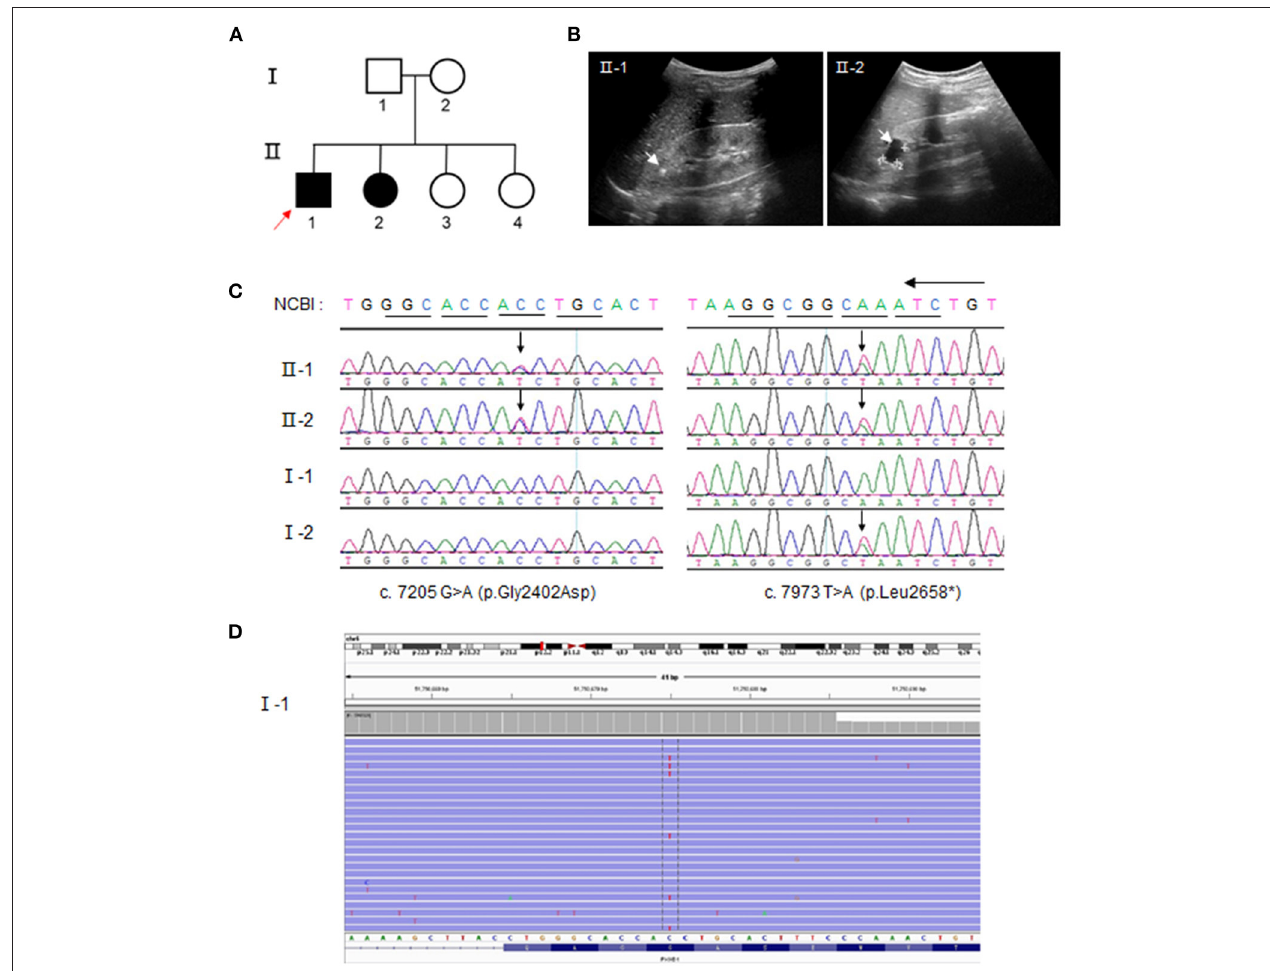
FIGURE 1 | Compound heterozygous polycystic kidney and hepatic disease 1 ( PKHD1 ) variants from parental mosaicism in a family with autosomal recessive polycystic kidney disease (ARPKD). (A) ARPKD pedigree. Squares = men; circles = women; Solid line = ARPKD patients; red arrow = proband. (B) Ultrasound images showing hyperechoic crystals and cysts in family members II-1 and II-2, respectively. (C) Identification of variants, c.7205 G > A and c.7973 T > A, by Sanger sequencing. The arrow indicates the position of the mutant base. (D) Unique Molecular identifier (UMI) and targeted-capture next-generation sequencing analysis (20,000 × ) for the low level of this c.7205 G > A (p. Gly2402Asp) variant, ∼ 7.404%, in the PBL of the father (I-1). The red base in the center of the reads denotes the “C” mutation to